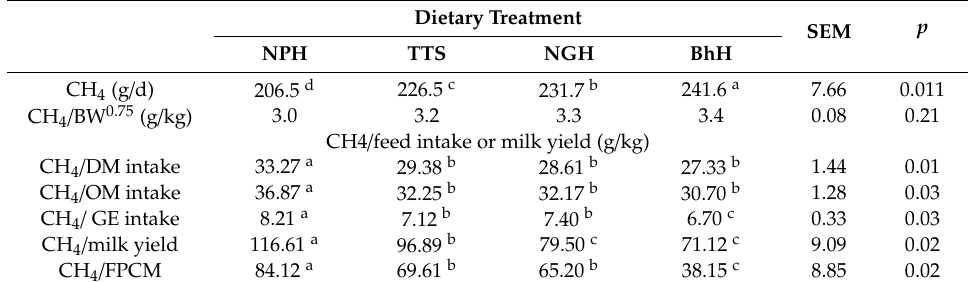
Table 6. Methane emission of lactating dairy cows fed natural pasture hay, treated te ff straw, Napier grass hay, and Brachiaria hybrid grass hay. Dietary